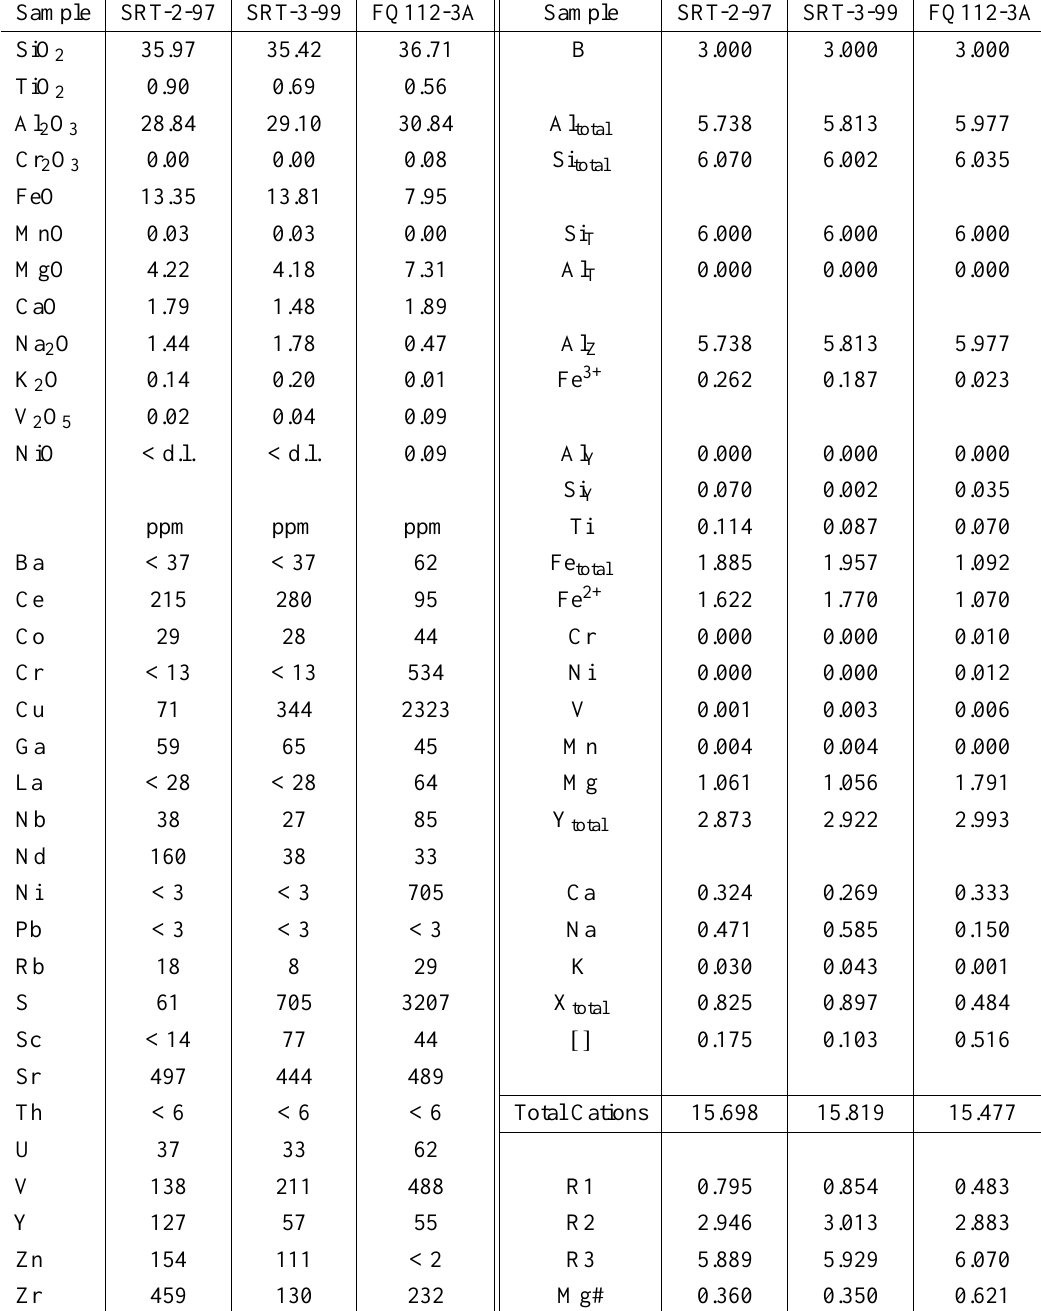
XRF analyses of tourmalines from Tapera Grande and Quartzito. Structural formulae calculated on 31 oxygen